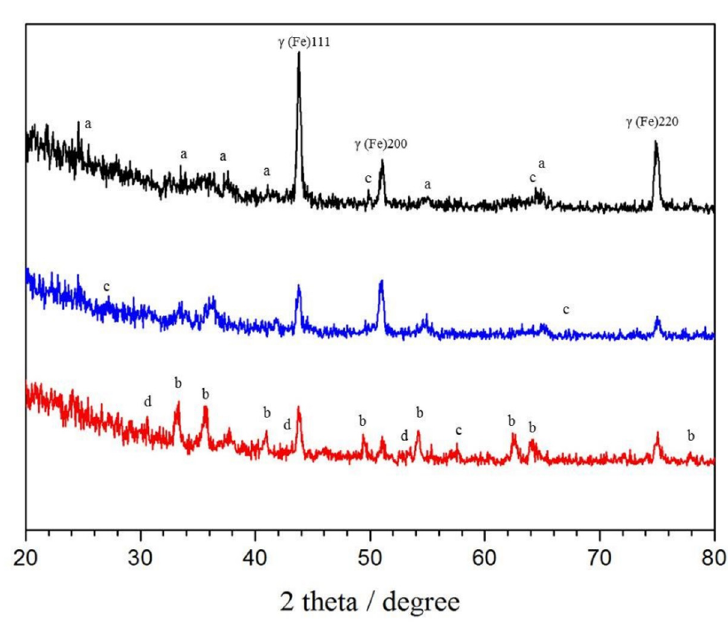
Figure 3. X-ray diffraction (XRD) patterns of the three groups of HR3C alloys after exposure to steam oxidation at 650 °C for 1000 h (a: Cr 2 O 3 , b: Fe 2 O 3 , c: Nb 2 O 5 , and d: FeCr 2 O 4 ).